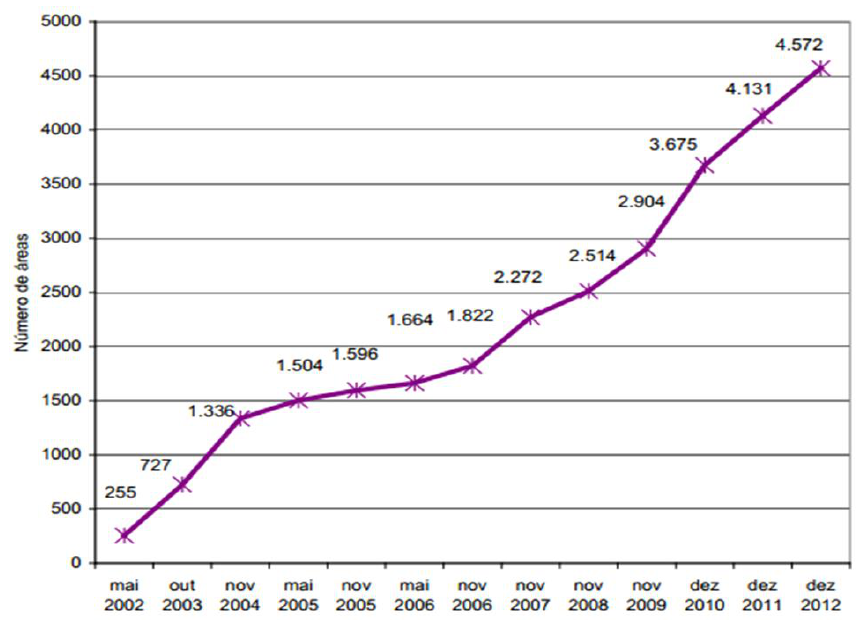
Figure 6. Evolution of the number of contaminated areas, 2002–2013.